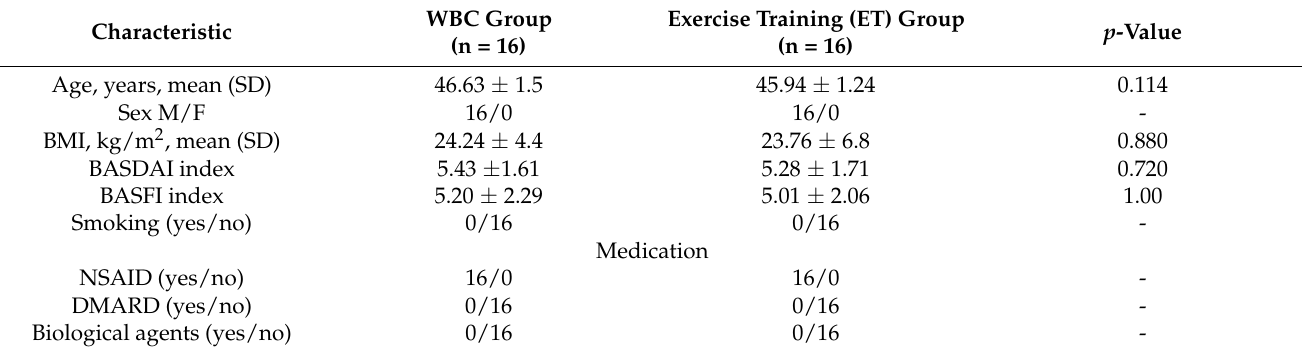
Table 1. Demographic data of the patients covered by the